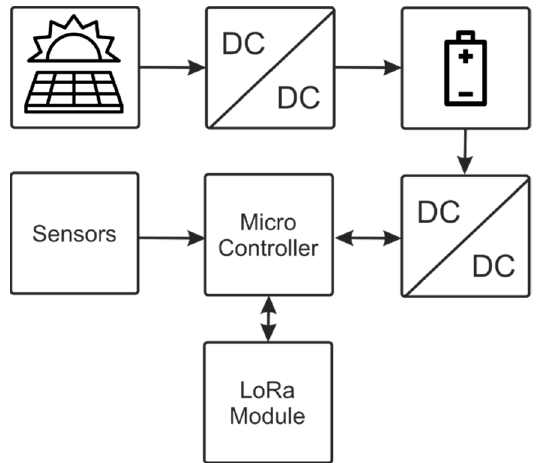
Figure 4. Block diagram of the charging system.